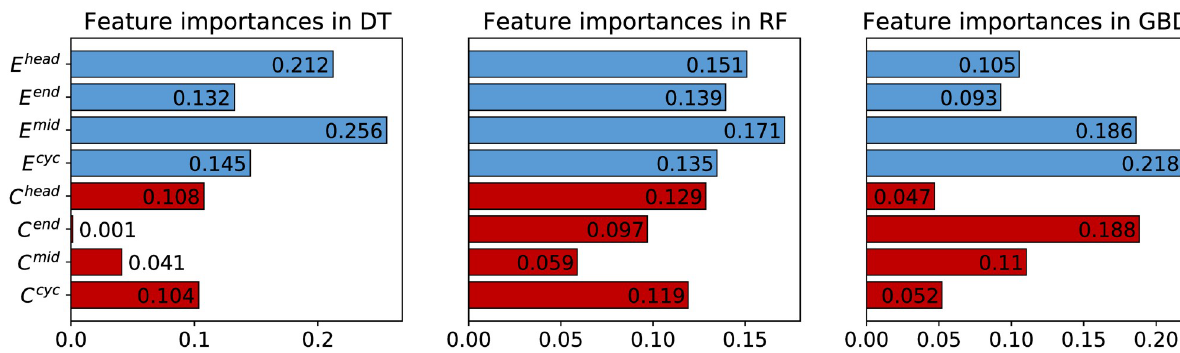
Fig 11. Importance scores of eight features in three tree-based models classifying network types. The scores of the four closure patterns are plotted in blue bars while those of the four clustering patterns are plotted in red bars.